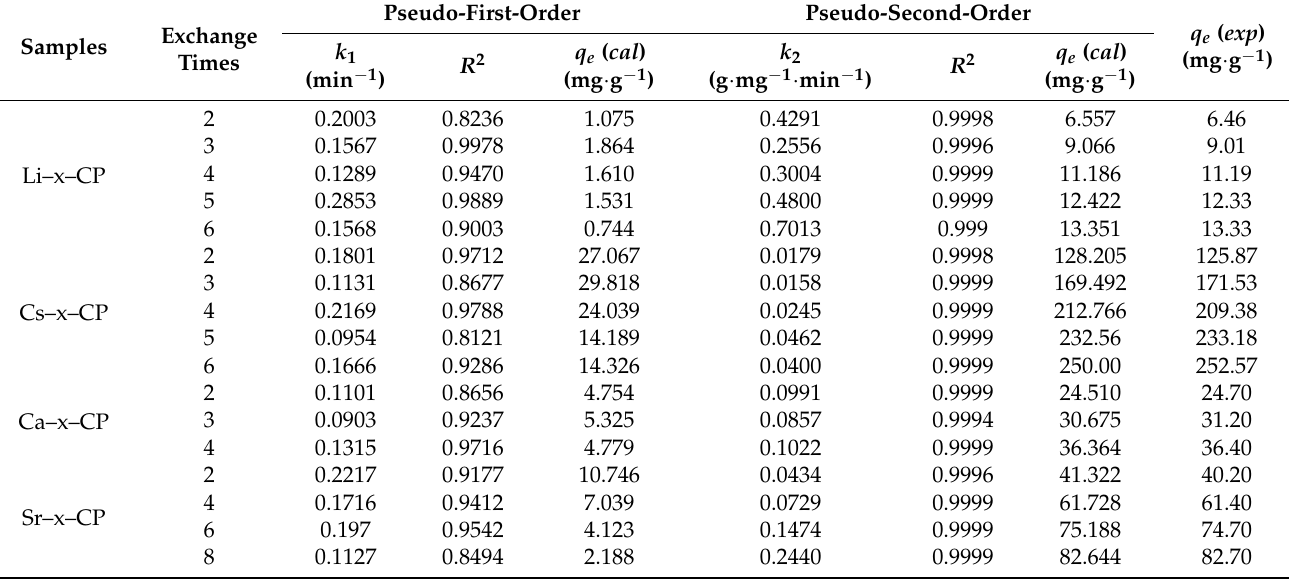
Table 3. Summaries for the kinetic constants of various cationic exchange